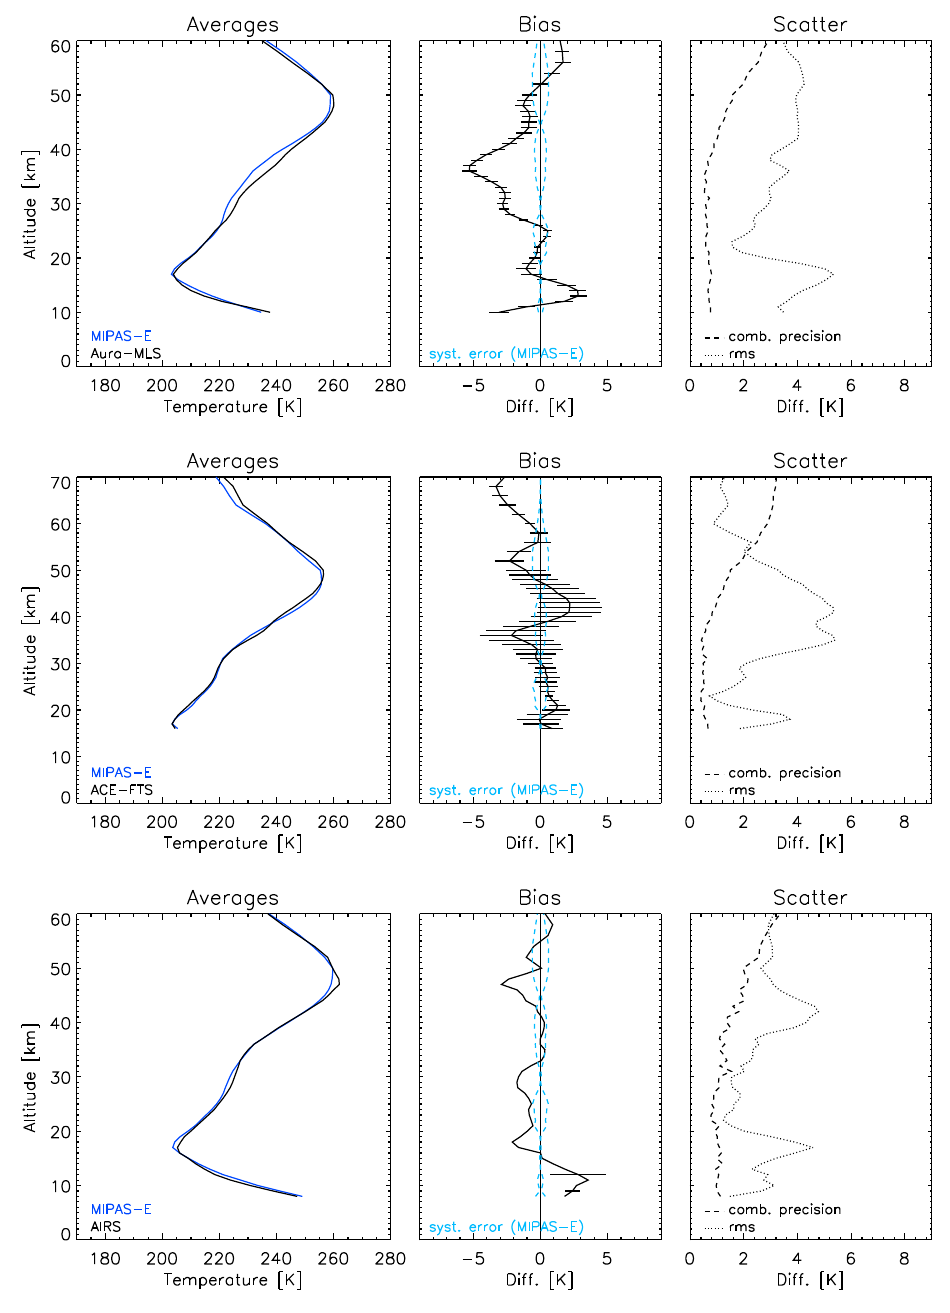
Fig. 7. Same as Fig. 2, but for Aura-MLS (top row), ACE-FTS (middle row), and AIRS (bottom row) temperature profiles. For a more detailed description see Fig. 2.